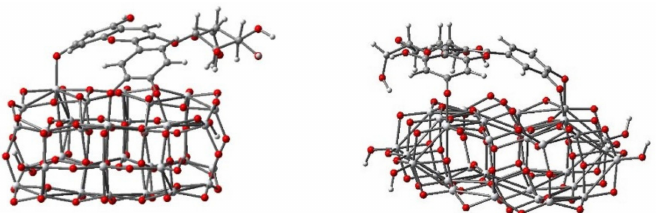
Figure 3. Adsorption modes of cyanidin 3-glucoside onto the titanium dioxide model cluster Ti 34 O 70 H 4 .